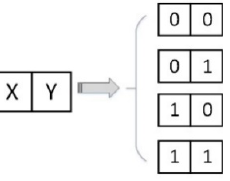
Figure 5. Data item representation of the Michigan method.